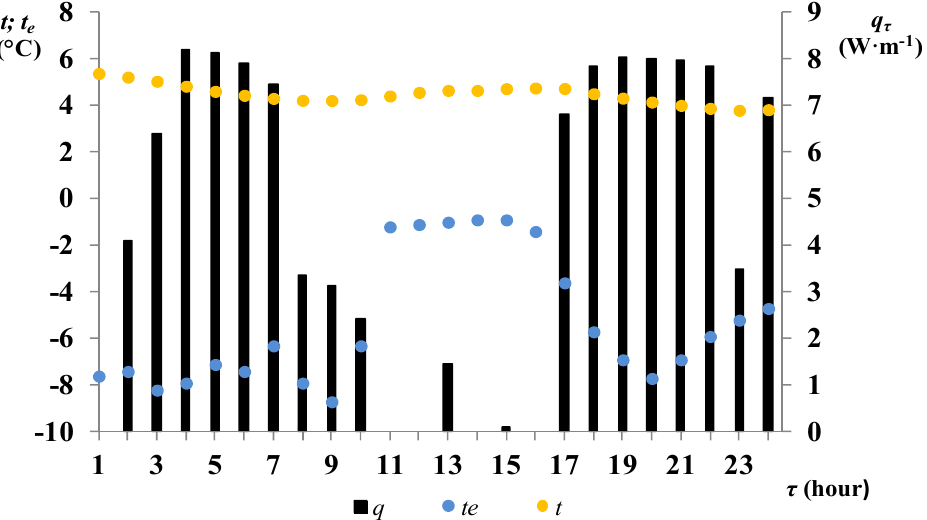
Figure 4. Temperatures of the soil and specific thermal output of the heat exchanger on a typical winter day 8 December